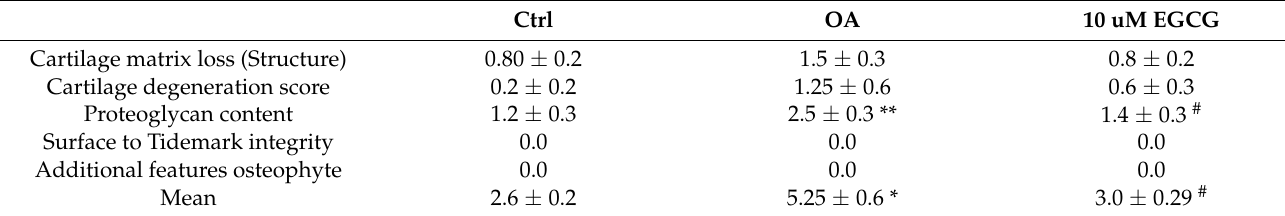
Figure 2. The histological analysis of osteoarthritis (OA) and the quantitative assessment of gly- cosaminoglycan (GAG) loss in the anterior cruciate ligament transection (ACLT) rats. ( a ) The repre- sentative micrographs of the proximal tibial cartilage with safranin O-fast green staining. ( b ) The quantitative analysis of GAG loss. No obvious arthritic changes or GAG loss was observed in the control group, but marked GAG loss was observed in the knee joints of ACLT rats. Meanwhile, the GAG loss was reduced after EGCG treatment. (** p < 0.01 OA vs. control; ## p < 0.01 OA vs. EGCG). Table 2. The results of OARSI. * p < 0.05 OA vs. control; ** p < 0.01 OA vs. control; # p < 0.05 OA vs.